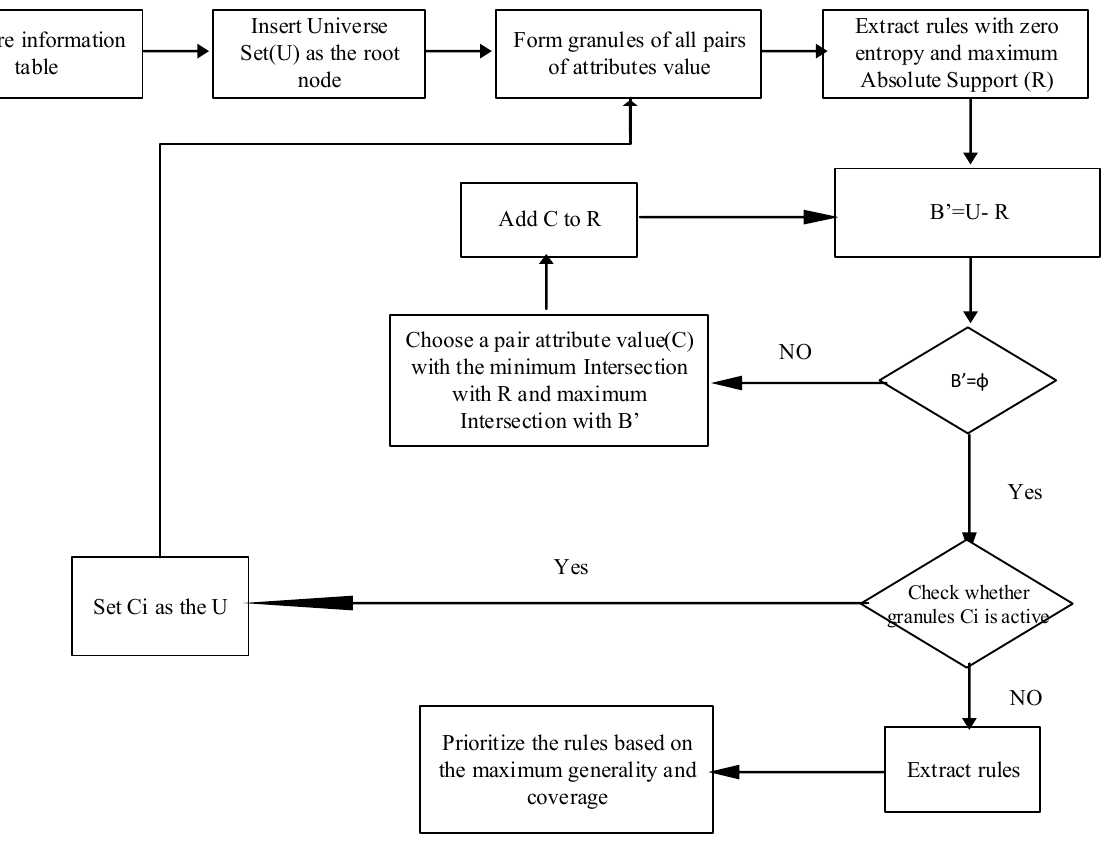
Figure 1. Procedure for extracting rules with granular